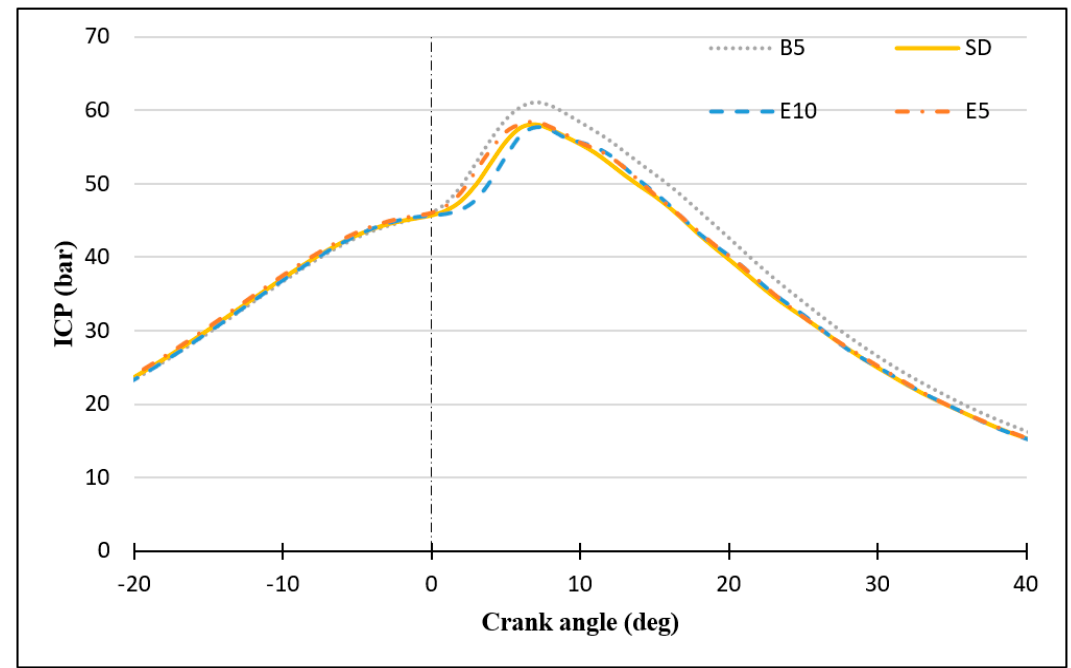
Figure 11. In-cylinder pressure traces for B5, E10, E5, and SD at 3 kW.